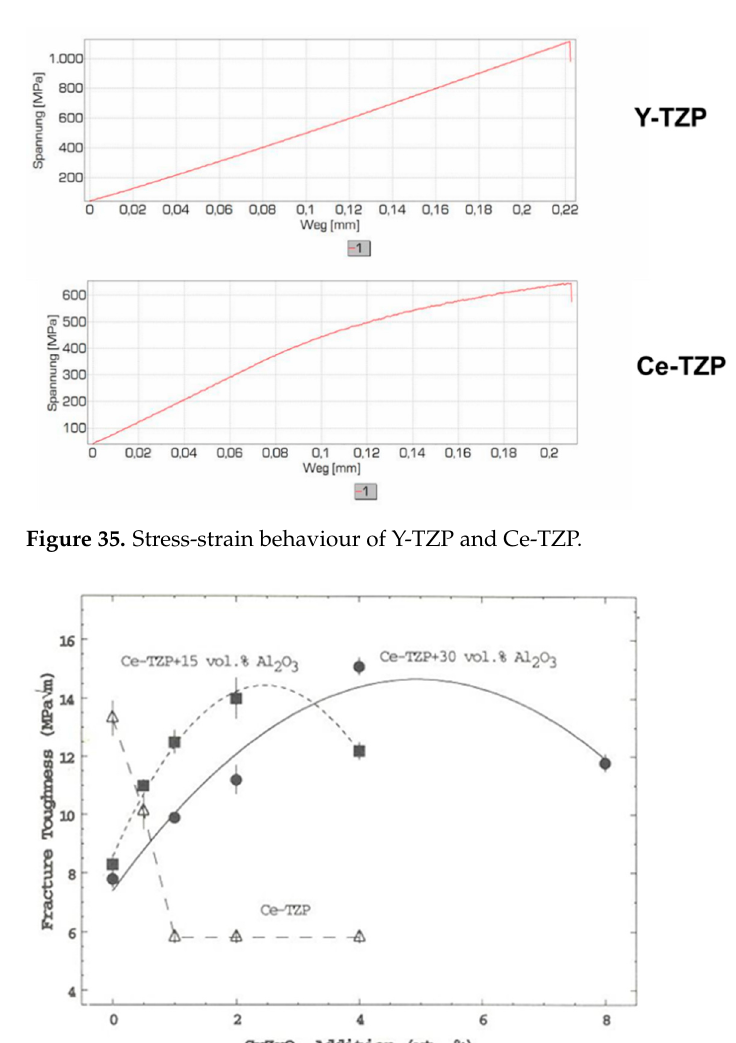
Figure 35. Stress-strain behaviour of Y-TZP and Ce-TZP.